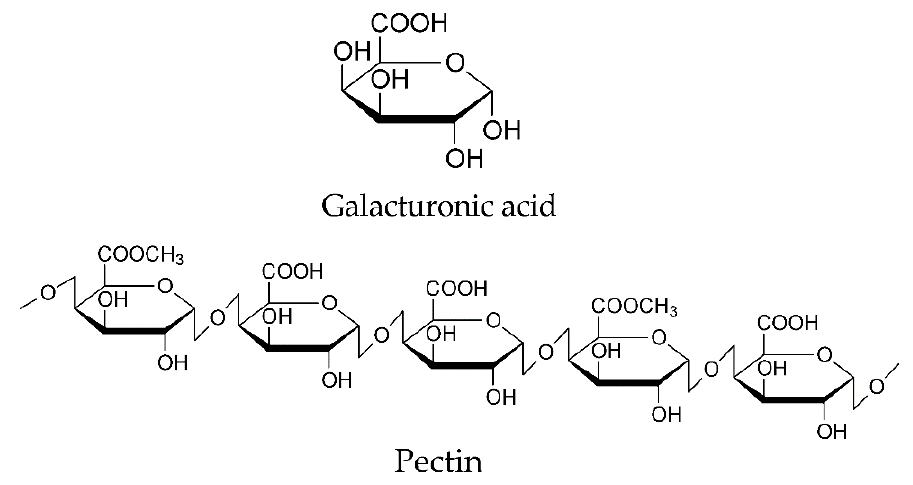
Figure 5. Structure of galacturonic acid and pectin.